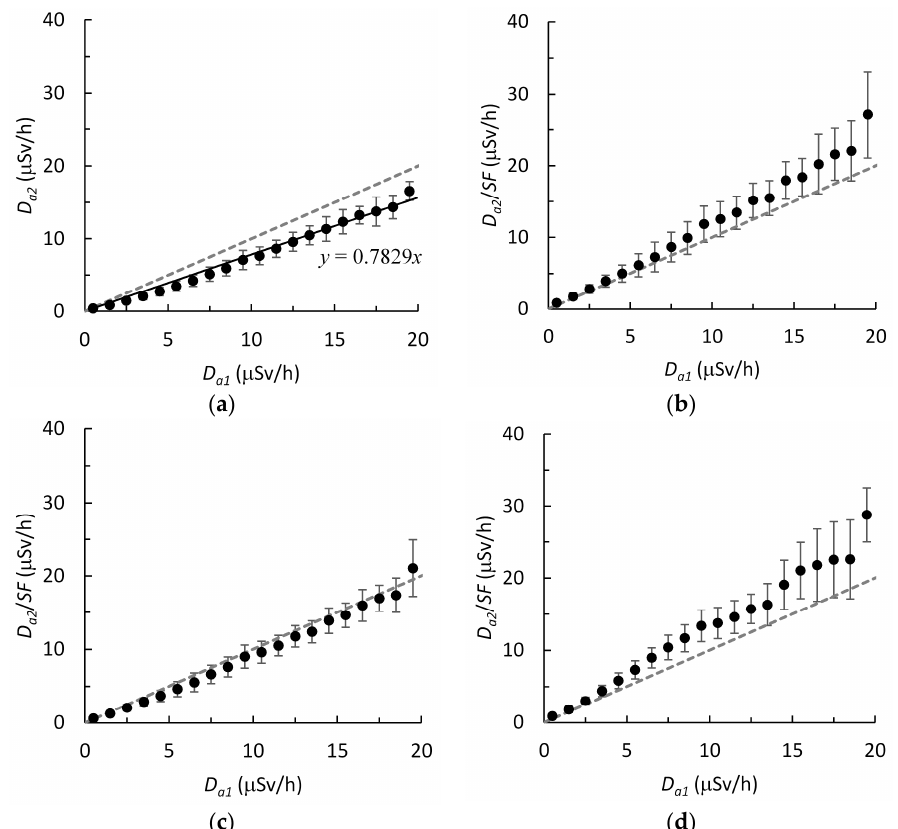
Figure 7. Relation between air dose rates before and after snowfall ( a ) without correction; ( b ) with correction using SF from results in PHITS2 and ρ a ; ( c ) with correction using SF from results in PHITS2 and ρ ( t ); and ( d ) with correction using the hydrological model. Dashed lines in each figure indicate the y = x line. The solid line in ( a ) indicates the fitted curve.